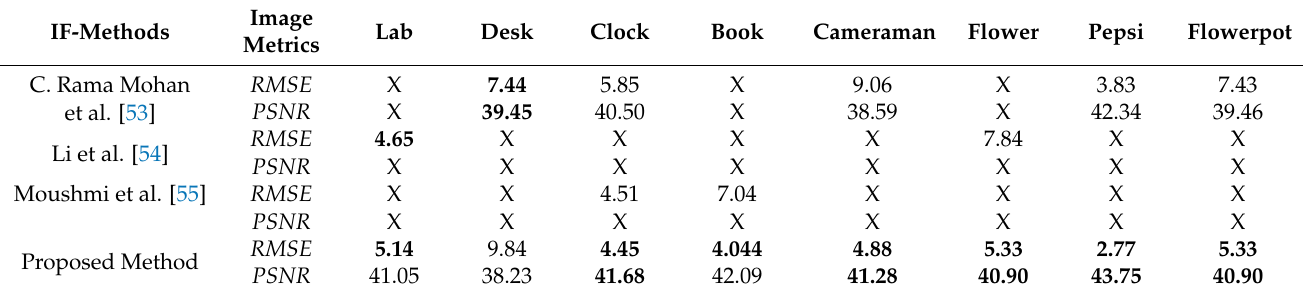
Table 2. For some images, the comparisons with approaches in the literature.